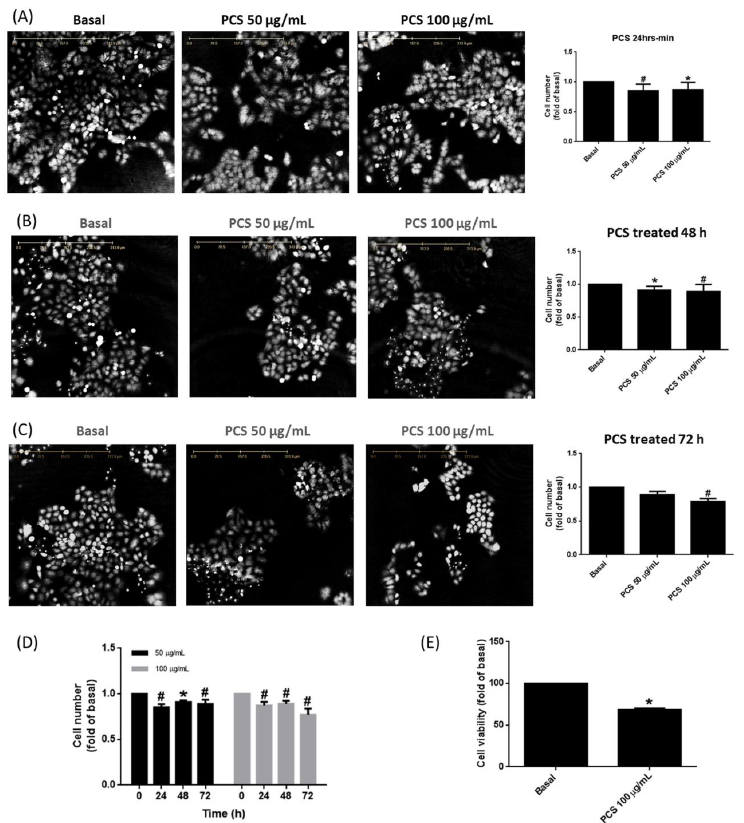
Figure 2. p-Cresyl sulfate (PCS) promotes human pulmonary alveolar cell death in a time- and dose-dependent manner. Serum-starved A549 cells were treated without or with PCS (50 or 100 μg/mL) for ( A ) 24 h, ( B ) 48 h, and ( C ) 72 h. ( D ) cells were treated with 50 or 100 μg/mL PCS for 0, 24, 48, or 72 h. At the end of incubation, holographic images were captured at least from five random areas. Cell number changes were analyzed by HoloStudio software. ( E ) Cell viability was analyzed by XTT assay according to the direction of manufacturer. Absorbance was measured at 490 nm and 650 nm using a BioTek spectrophotometer. Data are expressed as mean ± SEM of different independent experiments ( n > 5). * p < 0.05, # p < 0.01 as compared with the groups of Basal or 0 min. 3.3. Non-Specific Intracellular ROS Involves in PCS-Induced Alveolar Cell Death Cytotoxic effects of PCS are attributed to up-regulated NADPH oxidase activity [13,14], and mitochondrial dysfunction [19,20]. To investigate the mechanism further, phosphorylation of p47 phox protein was determined with or without the treatment of NADPH oxidase inhibitor (APO (10 μM) or DPI (0.1 μM)). We found PCS induced phosphorylation of p47 phox in a time dependent manner (Figure 3A). Pretreatment of APO and DPI attenuated p47 phox phosphorylation in PCS-stimulated cells (Figure 3A). On the aspect of mitochondria activation, A549 cells stained with MitoSOX TM Red were continuously exposed to 100 μg/mL PCS for 30 minutes. Figure 3B showed a sustained rise in